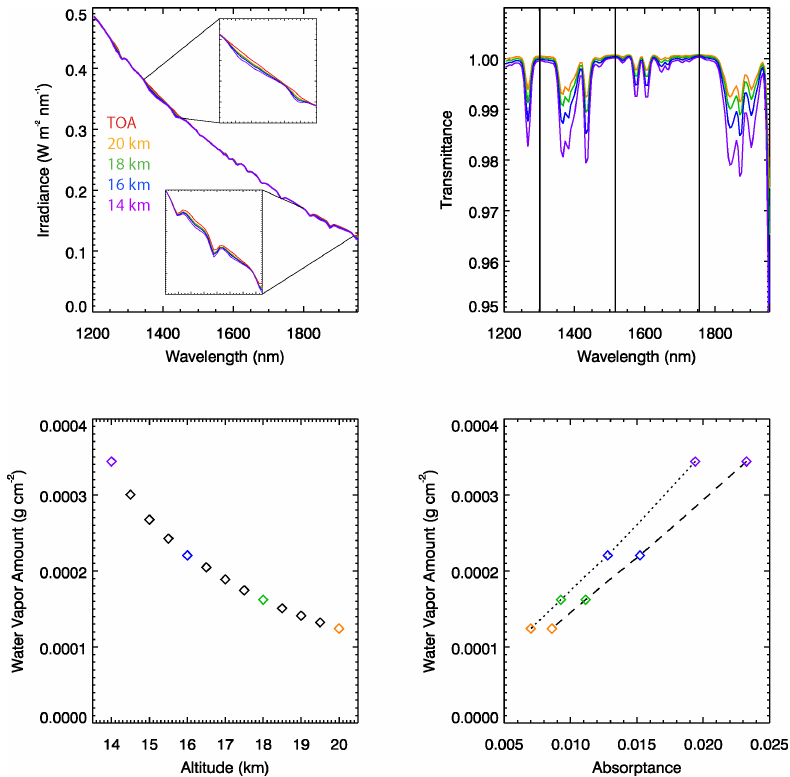
Figure 11. In the top left panel, modeled irradiances with expanded plots of the 1400 and 1900 water vapor bands are plotted. The top right panel shows the transmittance spectra for each altitude. In the bottom left panel, integrated water vapor amounts from the various altitudes to the TOA are plotted. In the bottom right panel, the integrated water vapor amount is plotted as a function of absorptance at 1367 (dotted line) and 1870nm (dashed